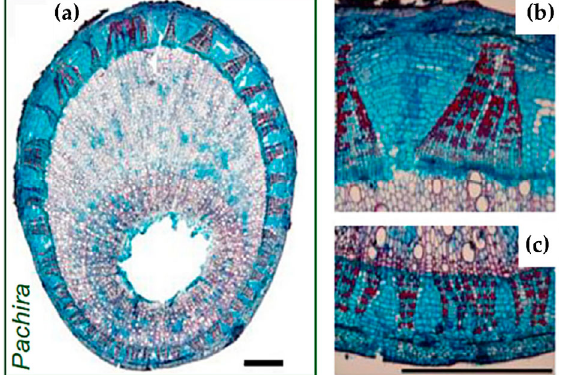
Figure 9. ( a , b ) Complete and severed grounded roots of Ficus altissima , with its cut surfaces sepa- rated by a distance of 3 cm (double-headed white arrow). Arrows indicate identifying marks [66]; ( c ) Secondary xylem of transected root * = parenchyma. ▲ = gelatinous fibers.